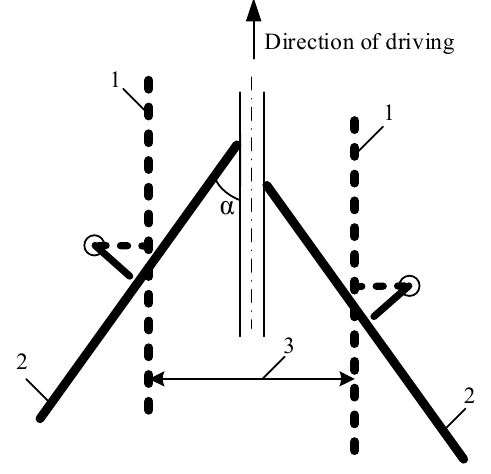
Figure 3. Adjustment of row cleaner parameters: 1—Discs held in parallel; 2—disc rotation; 3—gap between discs; α —slip angle.